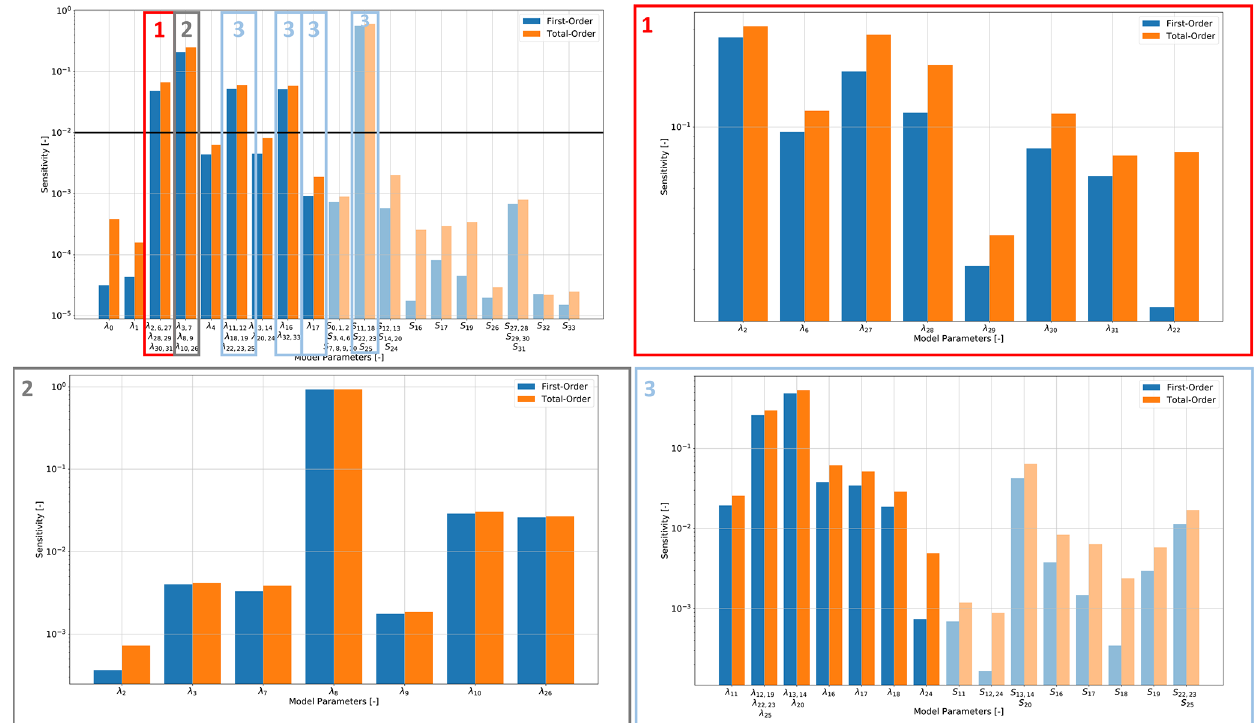
Figure 4. Representation of the hierarchical process-focused sensitivity analysis of the General-Focus Alps model. For the layer IDs and symbols, please refer to Table A1.